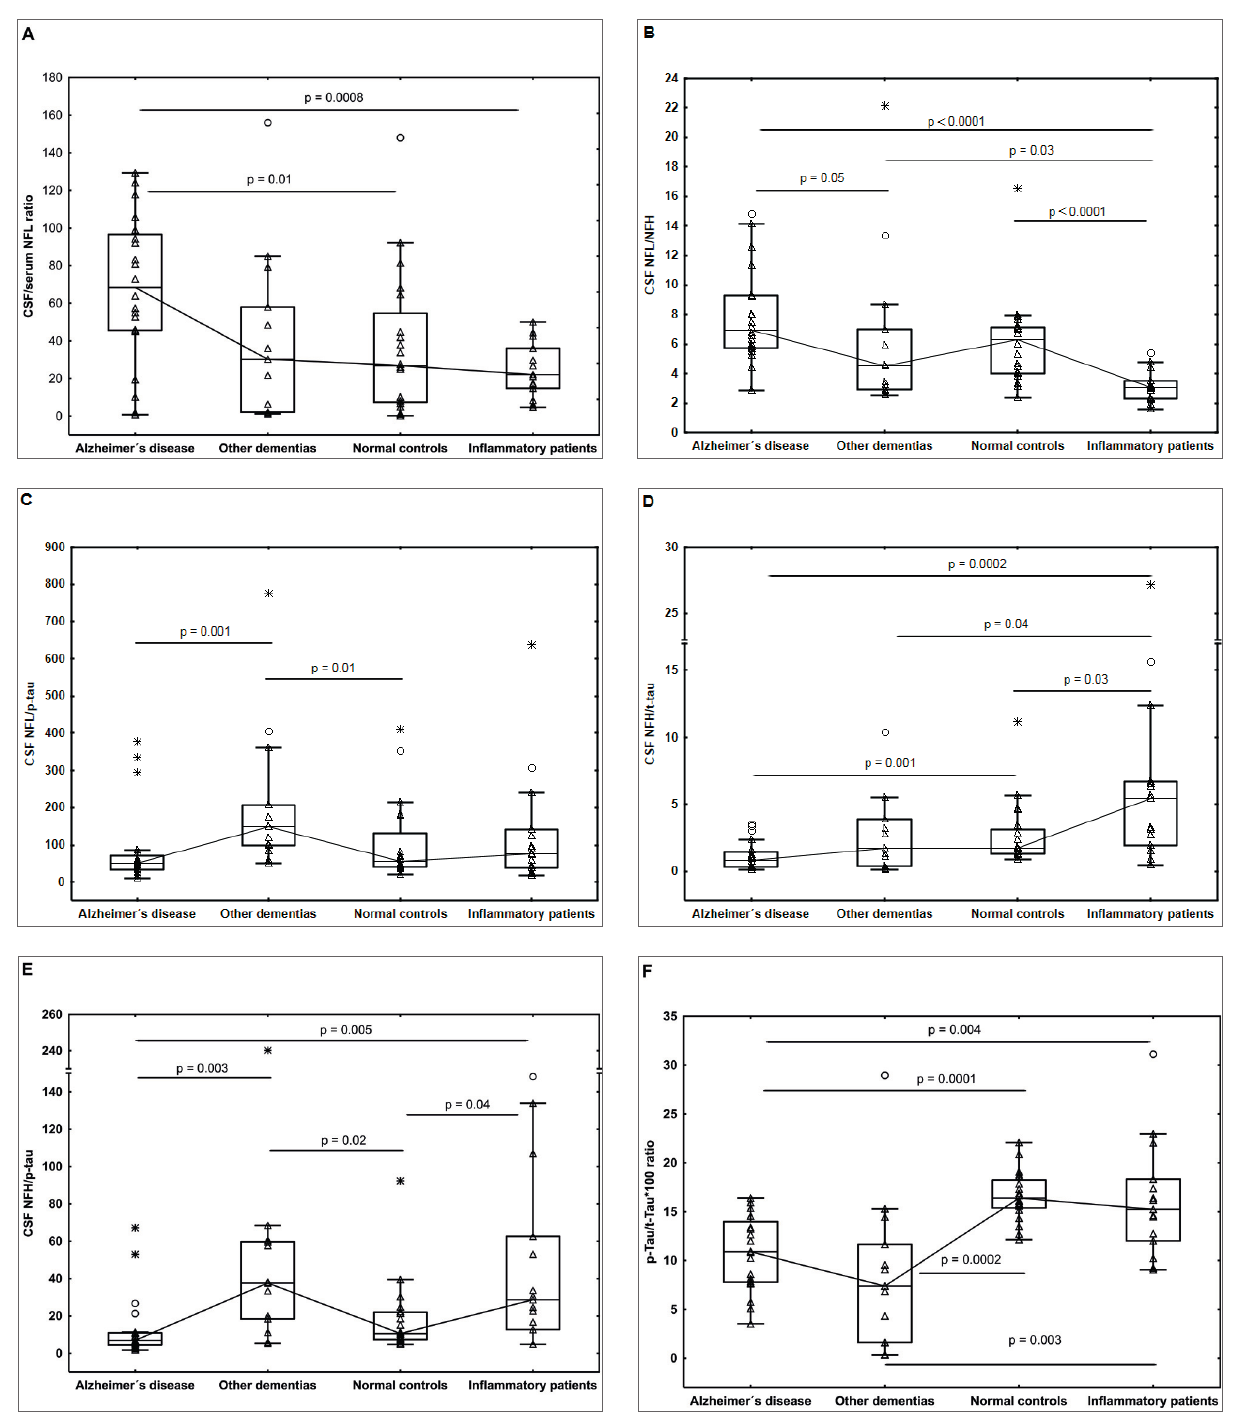
Fig. 2. Ratio comparisons among patients’ groups (A) CSF/serum NFL ratio; (B) CSF NFL/NFH ratio; (C) CSF NFL/p-tau ratio; (D) CSF NFH/t-tau; (E) CSF NFH/p-tau; (F) CSF p-tau/t-tau The ratios CSF/serum NFH and CSF NFL/t-tau, which did not differ among groups, are not shown. The box plots include median (horizontal line ─), values from the 25 th to the 75 th percentiles (boxes); bars (whiskers) above and below the box indicate the range of non-outliers. Non-outliers are indicated by triangles. Outliers and extremes are shown by circles and asterisks (the outlier values are outside the 1.5 box length from the upper and lower value of the box; the extreme values are outside the 3 box length from the upper and lower value of the